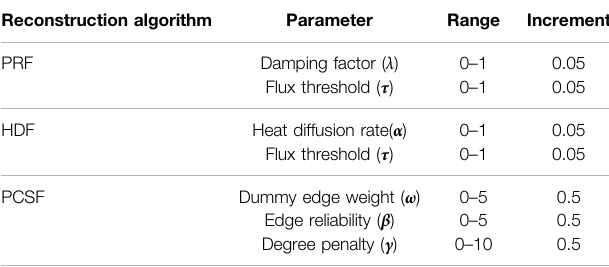
TABLE 2 | Tuning ranges of parameter sets in PageRank fl ux (PRF), heat diffusion fl ux (HDF), and prize-collecting Steiner forest. Reconstruction